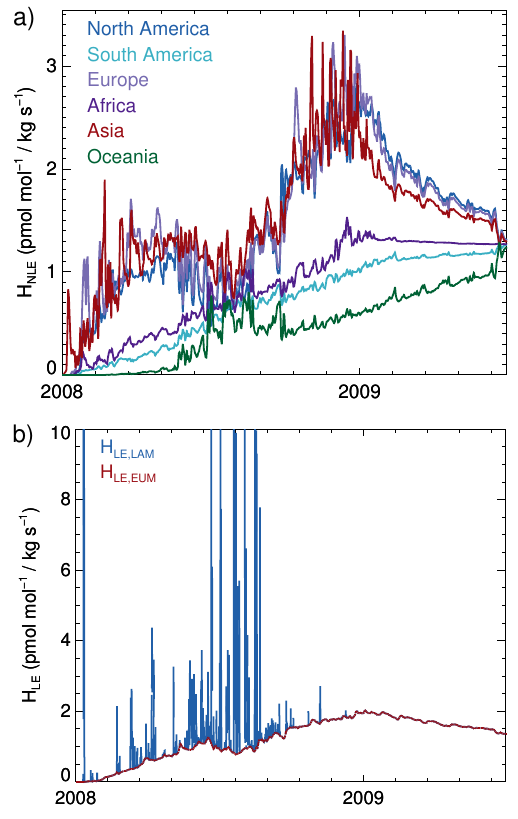
Fig. 2. The sensitivity of SF 6 observations at Gosan, South Ko- rea to: (a) perturbations in 2008 emissions from the six non-local regions used in the SF 6 inversion in Sect. 3; (a) changes in 2008 emissions from one grid cell close to the monitoring site. In (b) the red line shows the contribution that this emissions element makes to the background mole fraction, as calculated by the Eulerian model ( H LE , EUM ), whilst the blue line shows sensitivities calculated by the LPDM ( H LE , LAM ). The blue line has been added to the red line to show the overall sensitivity due to this grid cell (Equation